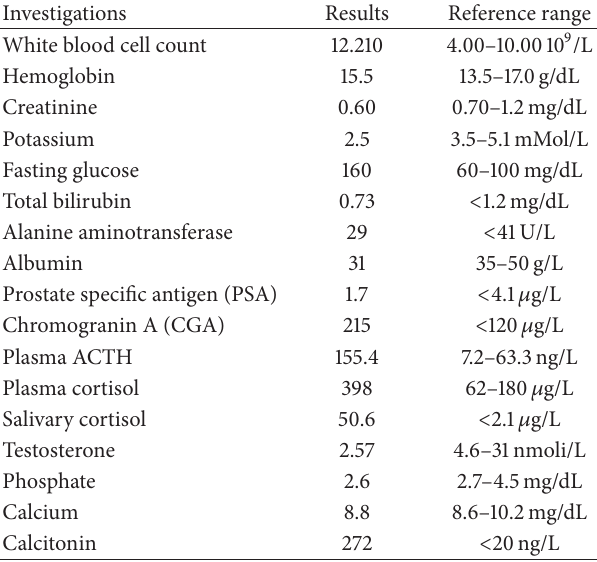
Table 1: Blood test results.